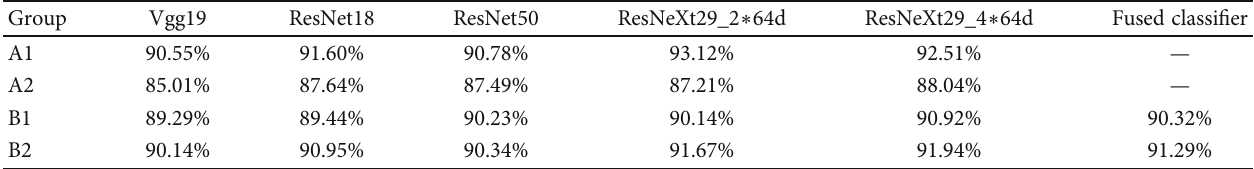
Table 3: Record of classi fi er